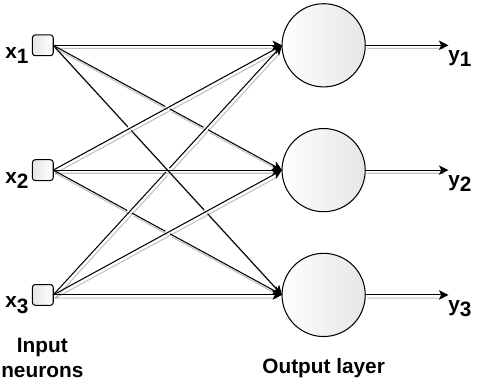
Figure 8. Example of single-layer feed-forward network with three inputs ( x 1 , x 2 , and x 3 ) and three outputs ( y 1 , y 2 , and y 3 ).